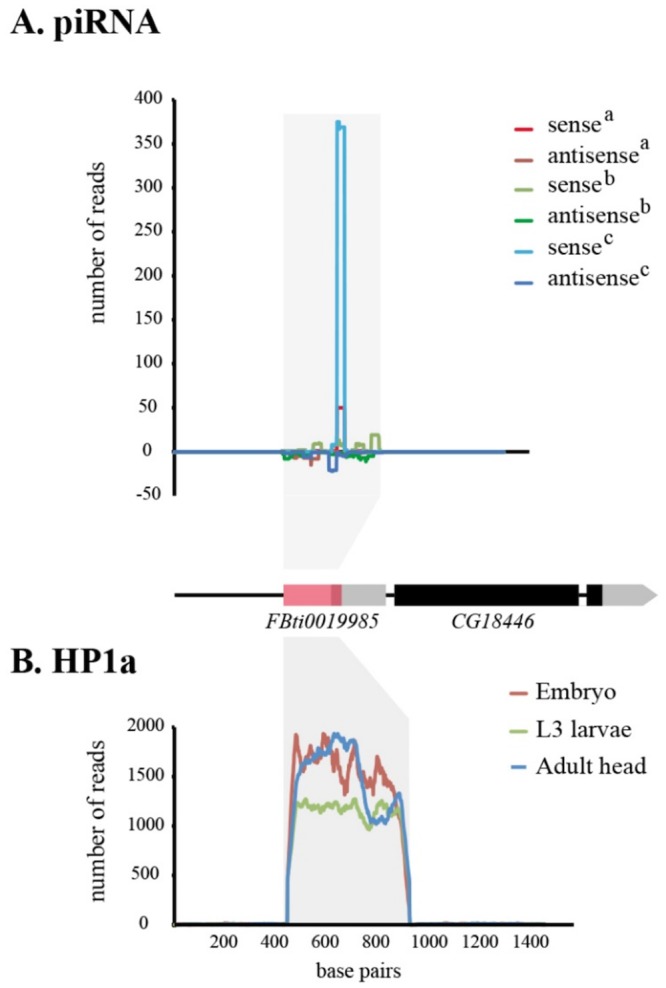
Mapping of piRNA reads and HP1a reads to the FBti0019985 region.(A) Number of piRNA reads mapped to a 1.4 kb region including FBti0019985. aLi et al (2009) piRNA library, bSatyaki et al (2014) piRNA library and cShpiz et al (2014) piRNA library. (B) Number of HP1a reads mapped to the same 1.4 kb region.